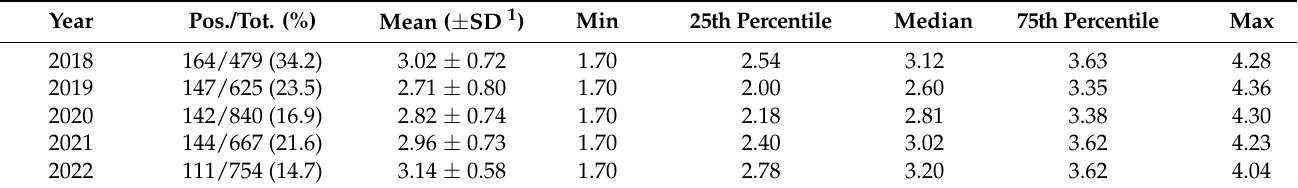
Table 4. Number of total samples, number of positive samples and percentage of positivity, geometric mean (Log 10 CFU/L) of positive samples, and descriptive statistics. Descriptive statistical analysis was conducted for the positive samples (N =